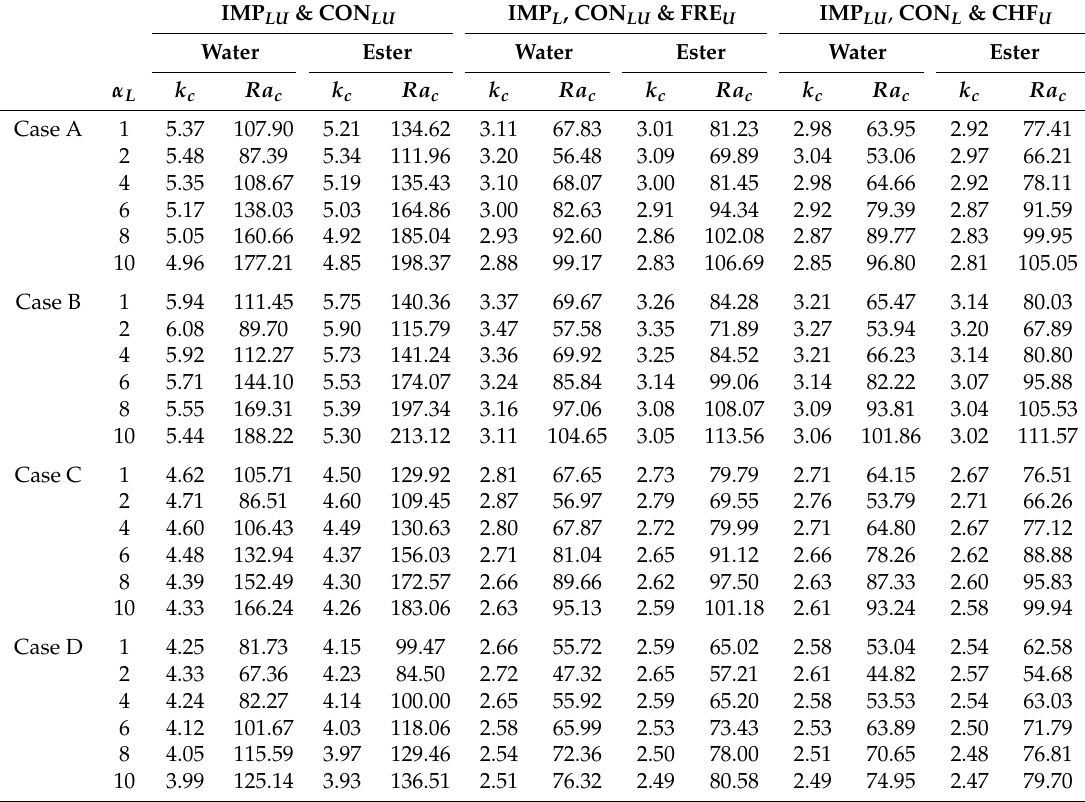
Table 2. The values of the critical internal Rayleigh number Ra c and the critical wave number k c for water- and ester-based